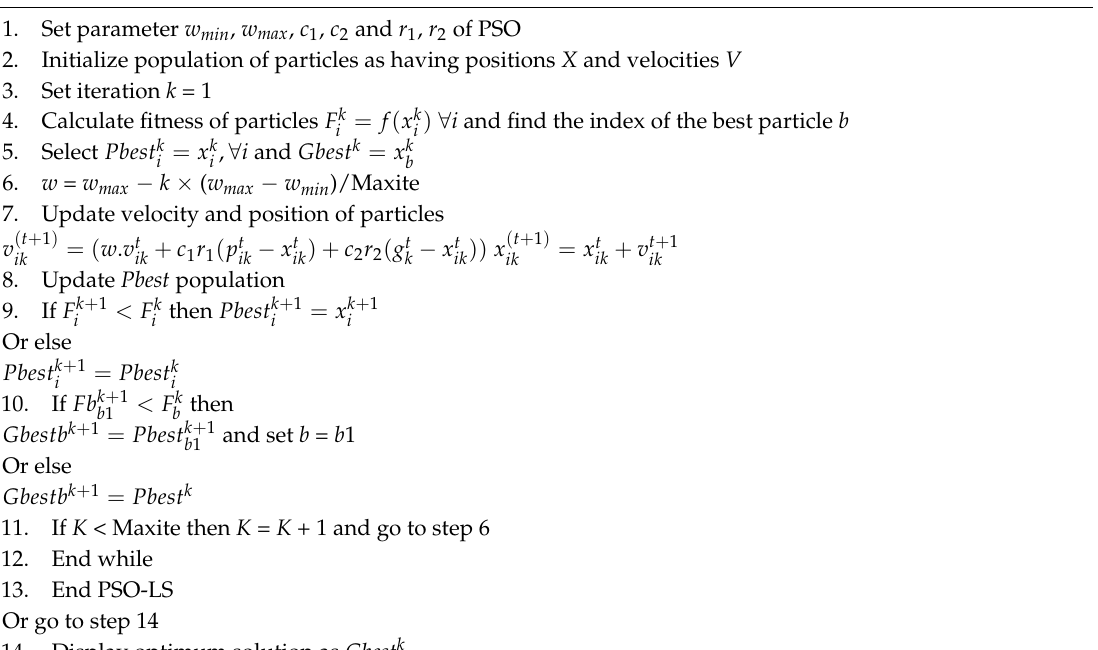
Algorithm 1 scale equations to the same size as the rest of the